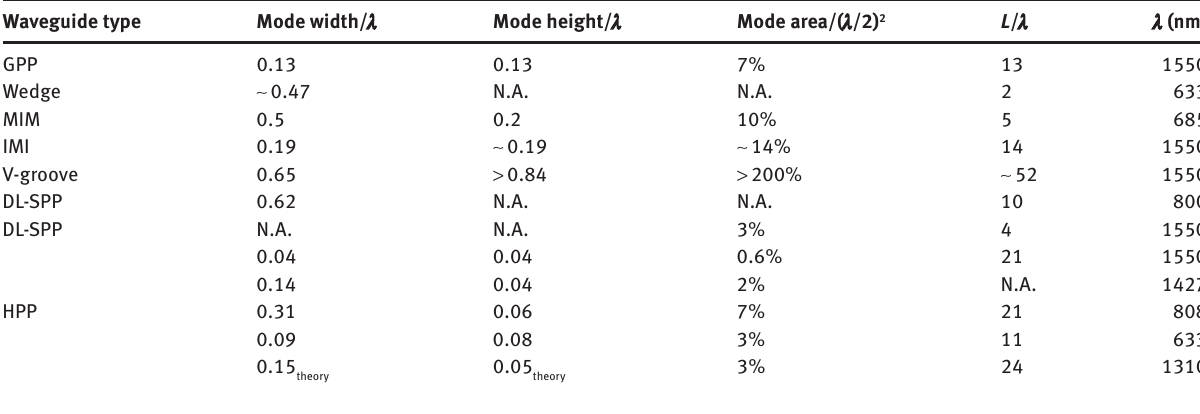
Table 1: Comparison of plasmon waveguide optical confinement (mode area), propagation length L and free space wavelength λ (from Ref.